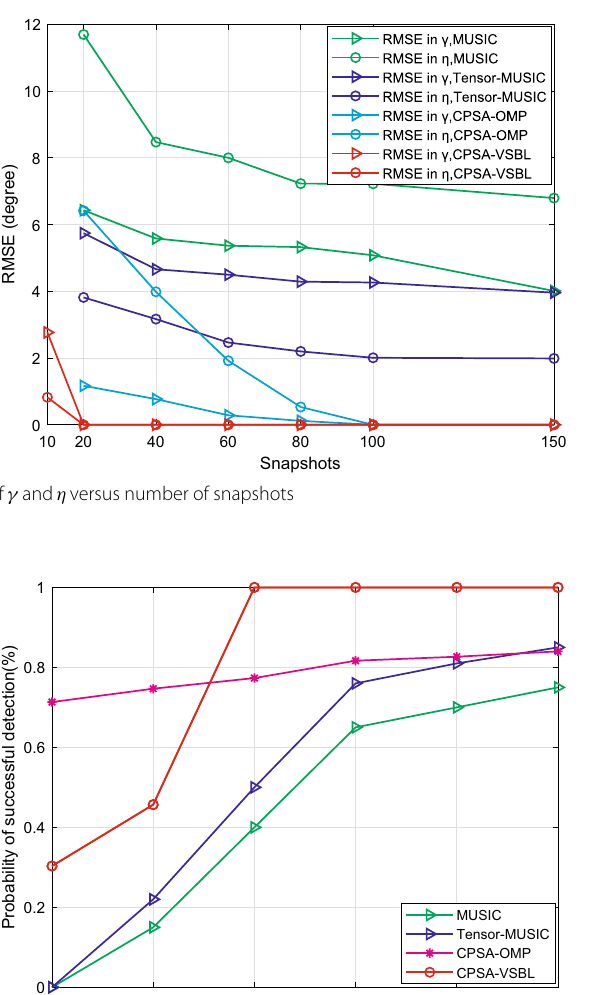
( − 8 ◦ , 45 ◦ , 10 ◦ , 30 ◦ ) and ( 2 ◦ , 45 ◦ , 30 ◦ , 20 ◦ ) , respectively. Set the number of snapshots is